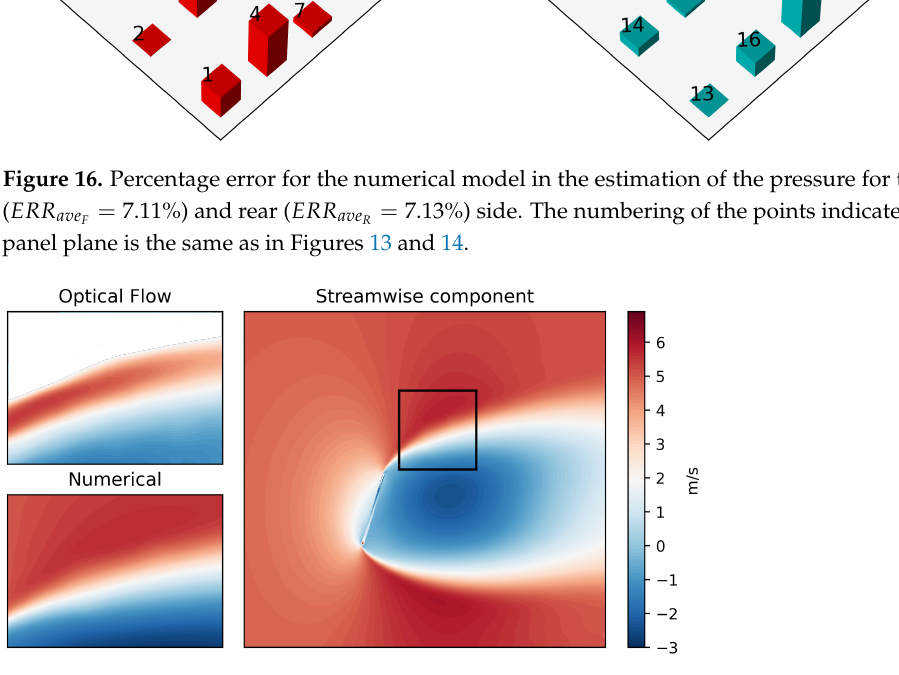
Figure 17. Numerical wind speed streamwise component on the plane parallel to the flow for the 5 m/s case with the comparison of the optical flow results ( left ).